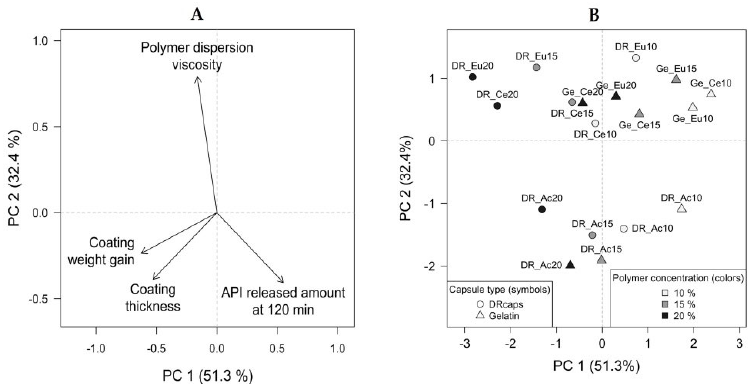
Figure 8. ( A ) PCA loadings plot; ( B ) PCA scores plot—capsule type differentiated by symbols, polymer concentration differentiated by colors, and polymer type differentiated by point labels.